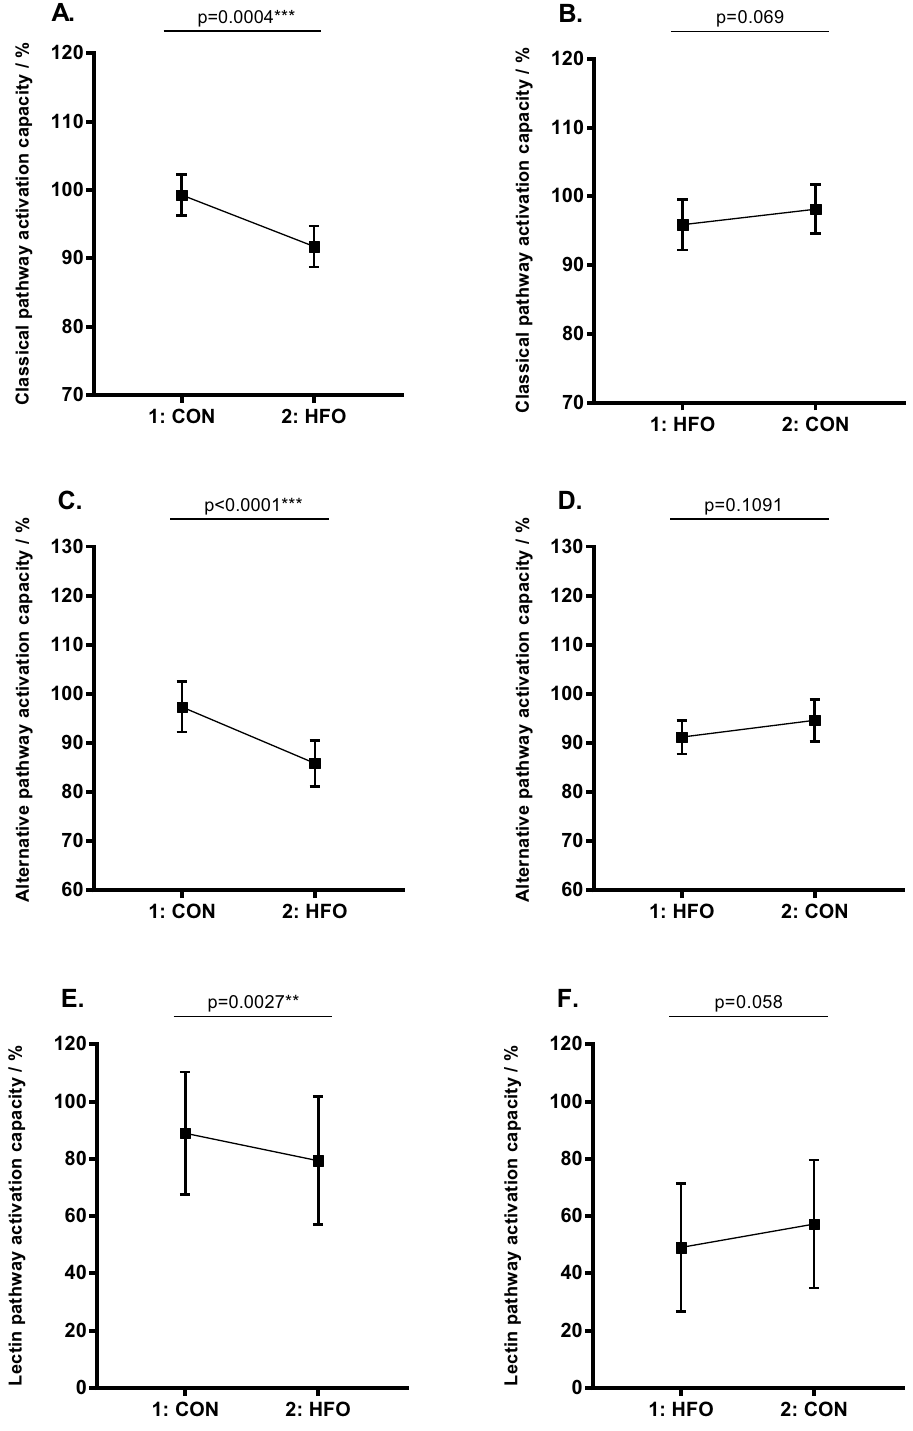
Figure 3. Reversibility of the impact of short term high-fat overfeeding on complement activation capacity. Comparison of the subjects that received the control diet first (n = 24) and the high-fat overfeeding diet 6–8 weeks after (diagram A , C , E ), with the subjects that received the high-fat overfeeding first (n = 19) and the control diet 6–8 weeks after (diagram B , D , F ). Data are reported as means with 95% CI. Paired two-tailed t-test p-values represent the difference in functional complement activation capacity of the different complement pathways after control diet vs. after overfeeding. Please note the Y-axis benchmark in diagram ( A and B ) is 70, in diagram ( C and D ) 60, and in diagram ( E and F ) 0. CON, control diet; HFO, high-fat overfeeding; 1 = first study period; 2 = second study